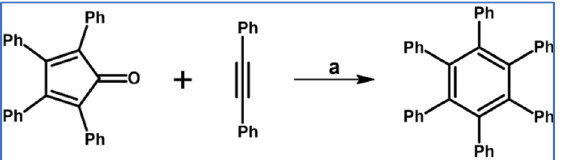
Scheme 3. Model reaction for the DA cycloaddition with CO extrusion: synthesis of hexaphenylben- zene via DA cycloaddition of tetraphenylcyclopentadienone and 1,2-diphenylacetylene. Reagents and conditions: a = benzophenone, rfx, approx. 45 min, Y = 84%.